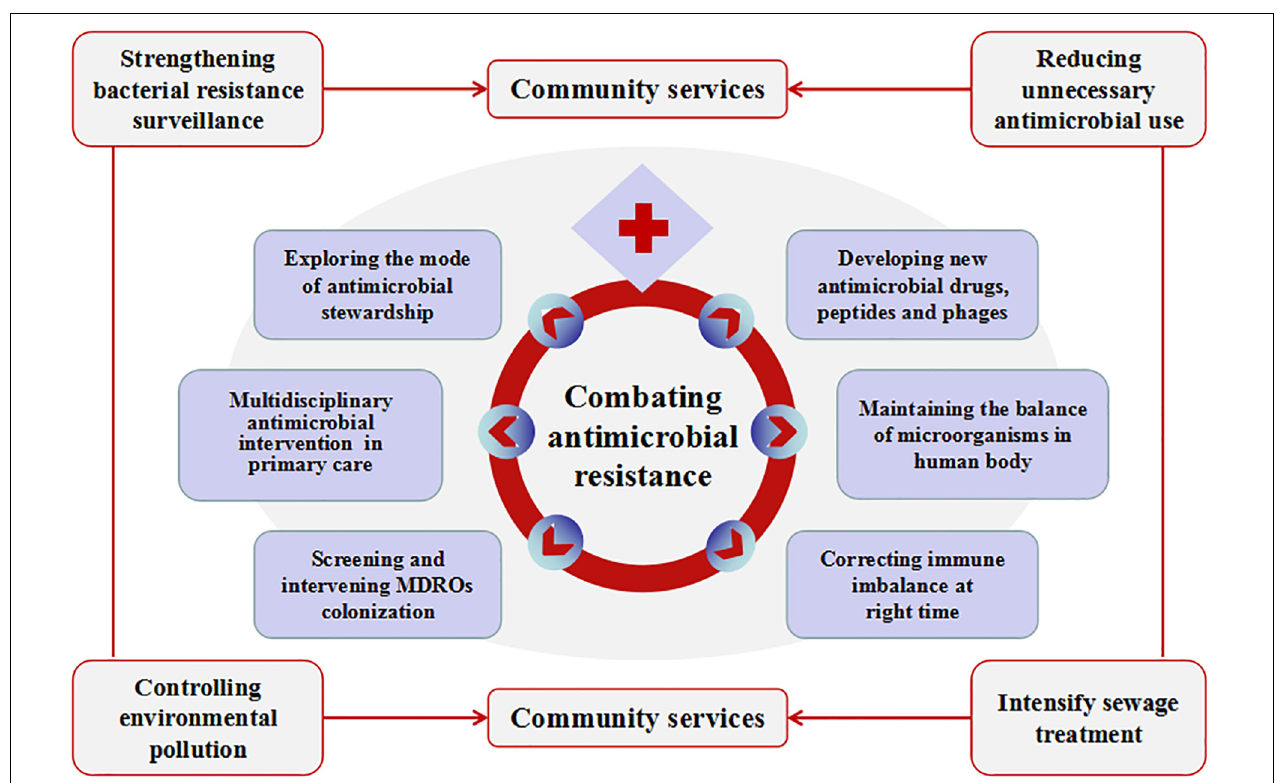
FIGURE 2 | Measures to be taken to combat antimicrobial resistance in China. Combating antimicrobial resistance, we need to carry out the work from community service and medical institutions. Community service includes strengthening bacterial resistance surveillance, reducing unnecessary antimicrobial use, controlling environmental pollution and intensify sewage treatment. Other measures that can be implemented in medical institutions include exploring the mode of antimicrobial stewardship, multidisciplinary antimicrobial consults in primary health care; screening and intervening multidrug-resistant organisms’ colonization; developing new antimicrobial drugs, peptides and phages; maintaining the balance of microorganisms in the human body and correcting immune imbalance at the right